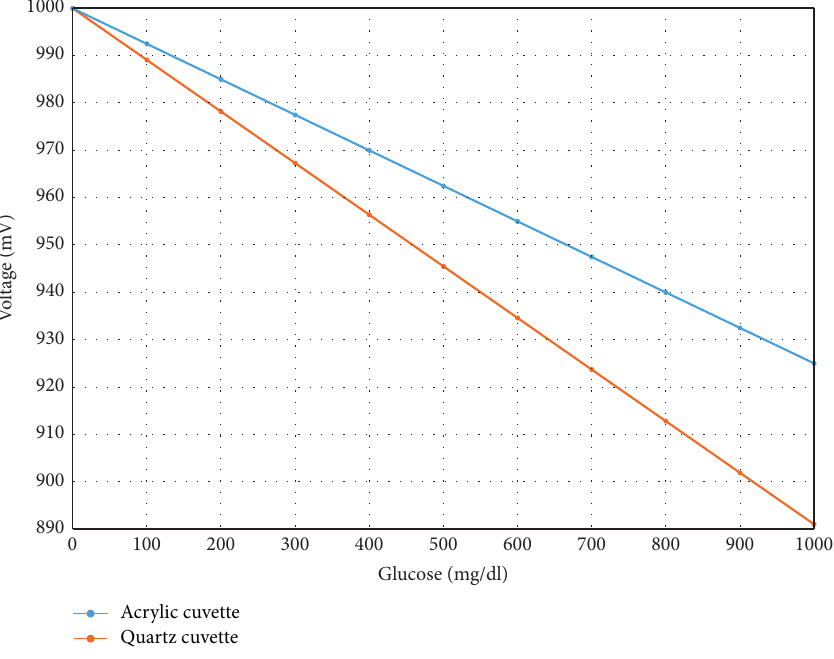
Figure 8: Cuvette performance comparison for glucose measurement. Table 4: Average downward voltage pattern.